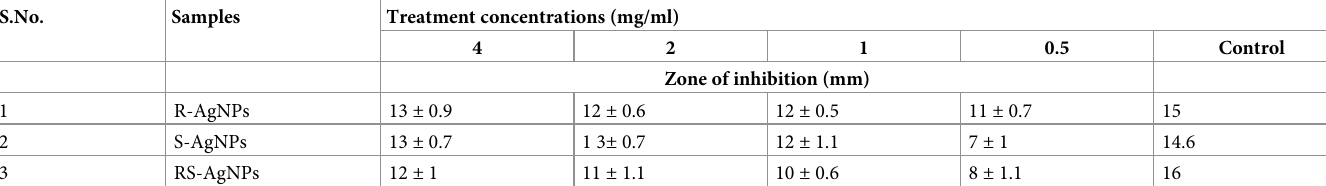
Table 2. Protein kinase inhibition potential of R-AgNPs, S-AgNPs and RS-AgNPs using Streptomyces 85E strain. S.No.